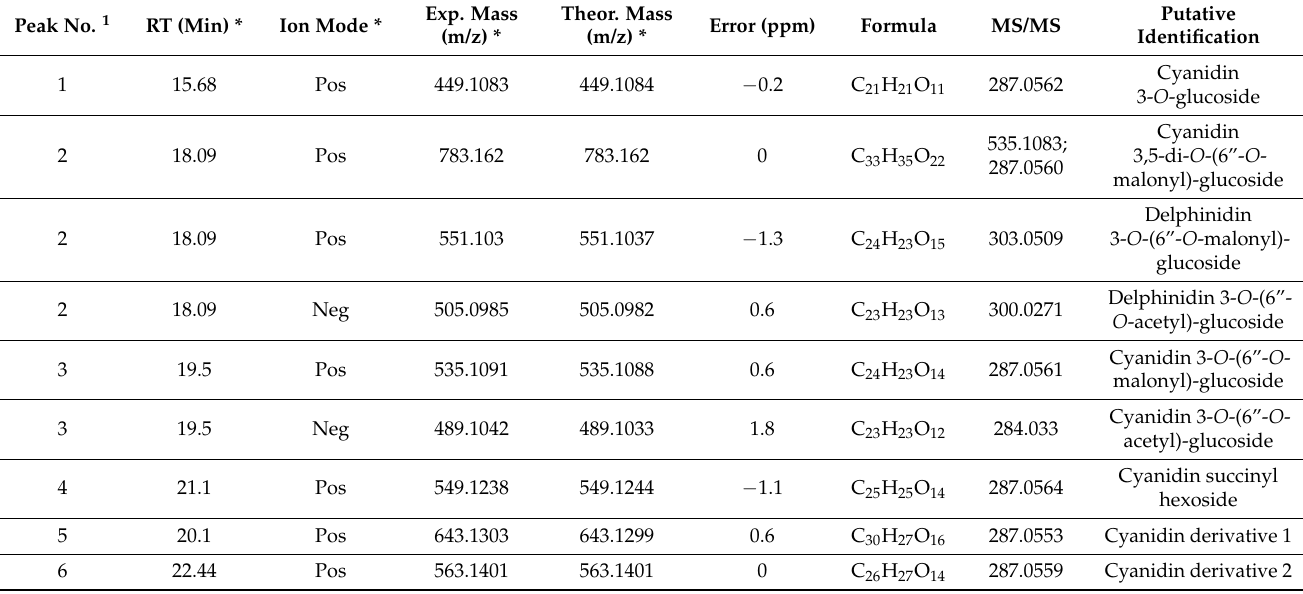
Table 2. Putative anthocyanins in red chicory identified by